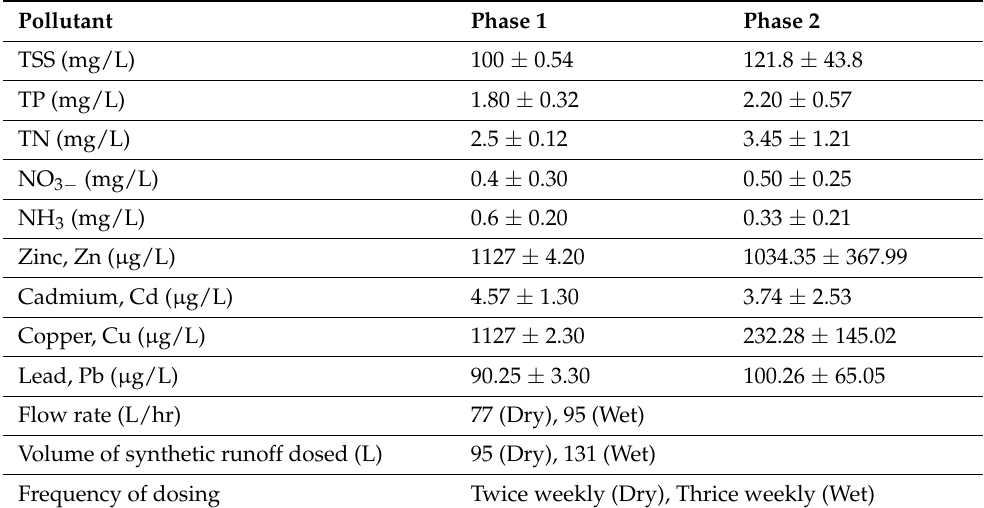
Table 1. Average pollutant concentration and dosing regimens for Phase 1 and Phase